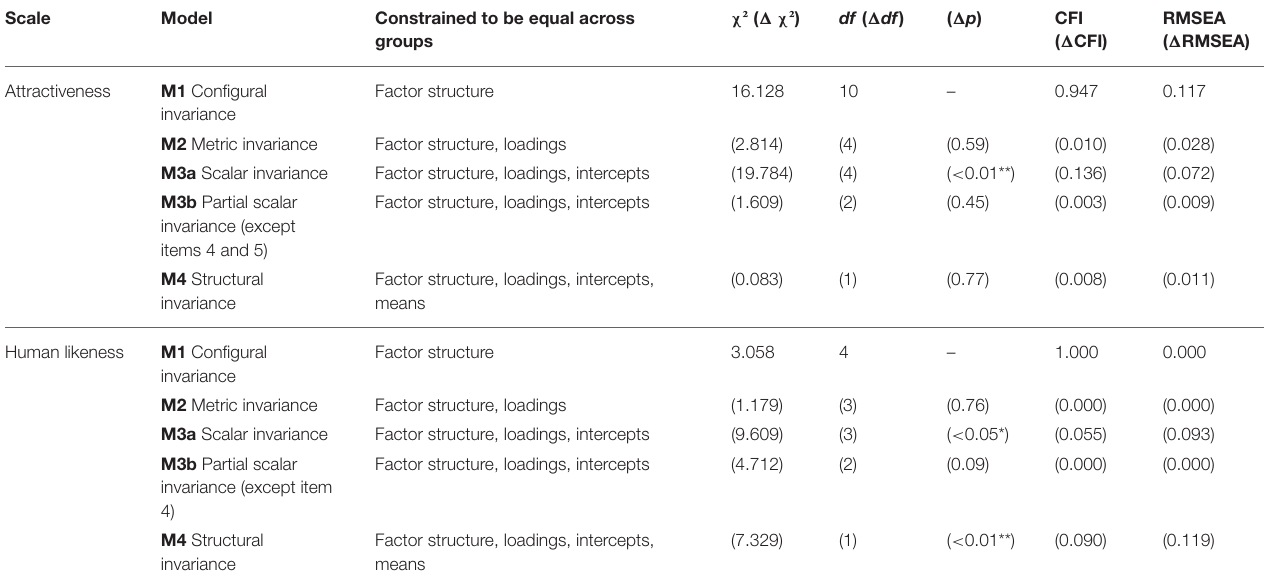
TABLE 1 | Multi-group confirmatory factorial analyses to check translated scales for measurement invariance.